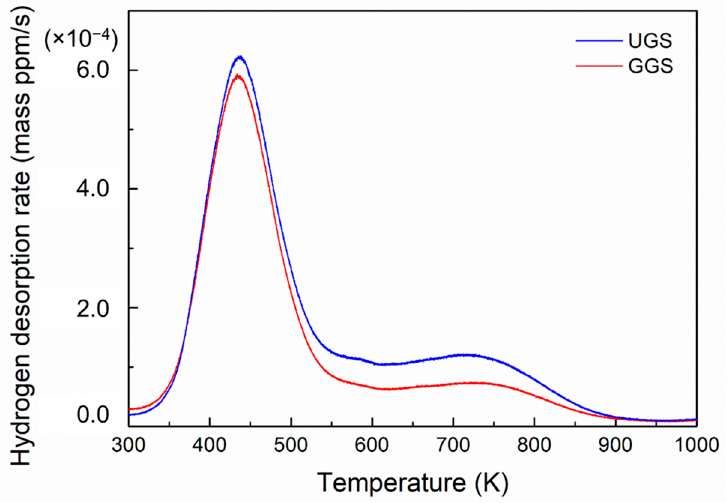
Figure 3. Fracture surface of the investigated materials in the ( a – d ) monotonic and ( e – h ) cyclic deformation modes. The images were obtained ( a , b , e , f ) before and ( c , d , g , h ) after hydrogen charging at a current density of 30 A·m − 2 for 6 h at 360 K.